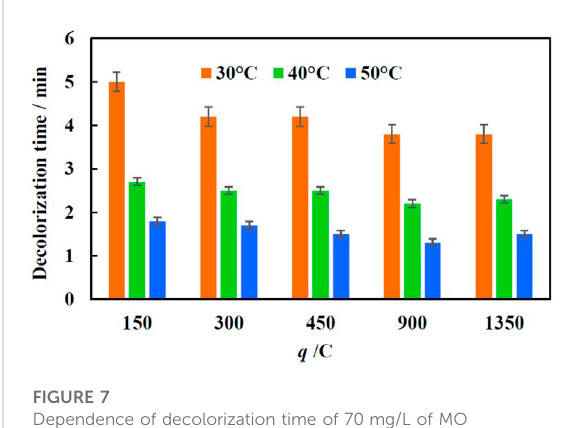
FIGURE 7 Dependence of decolorization time of 70 mg/L of MO solution (H 2 O 2 conc. — 90 µL) on temperature and amount of electric charge applied for iron deposition conditions. FIGURE 8